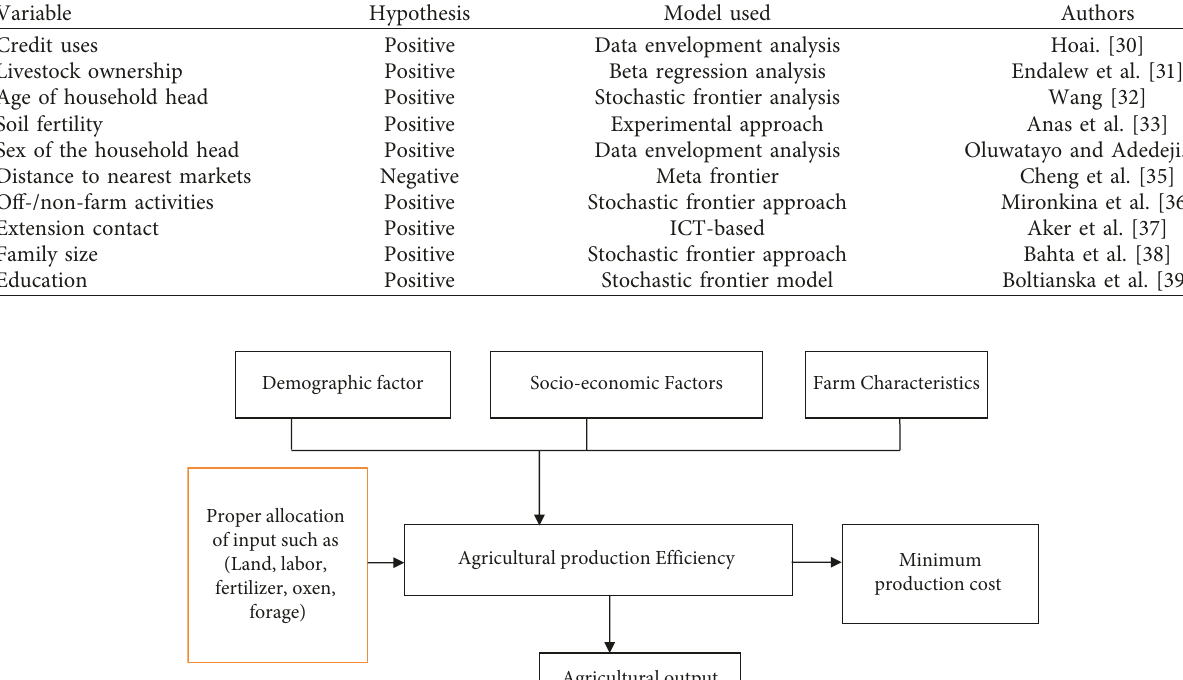
Table 1: Determinant of efficiency variable hypothesis.